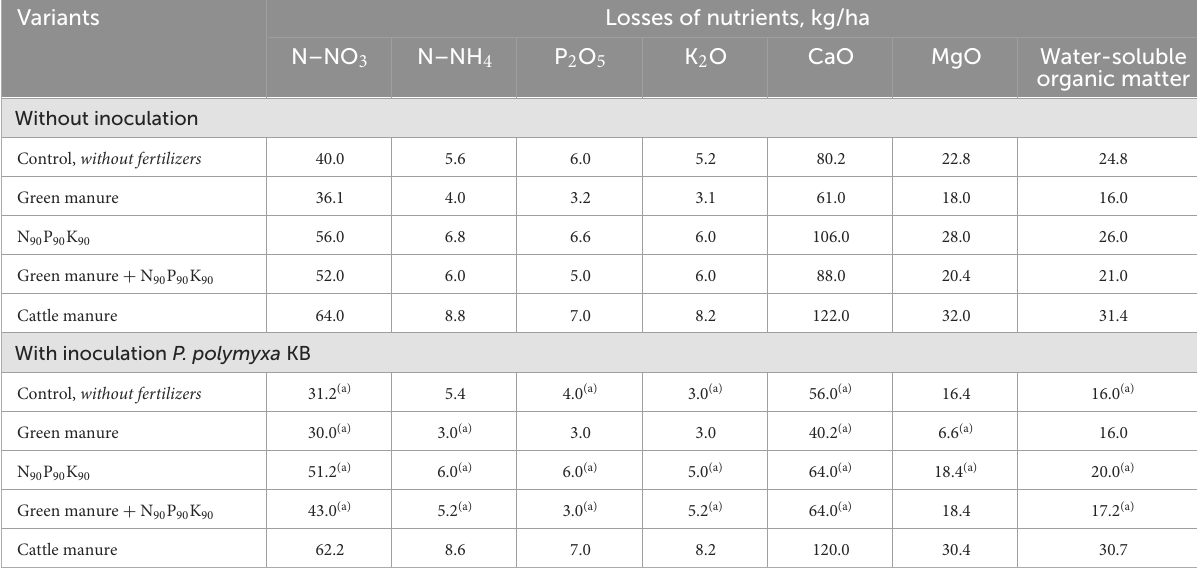
TABLE 3 The effect of fertilizers and pre-sowing maize seeds inoculation with P. polymyxa KB on losses of nutrients and water-soluble organic matter with drainage waters (May–September 2018) . Variants